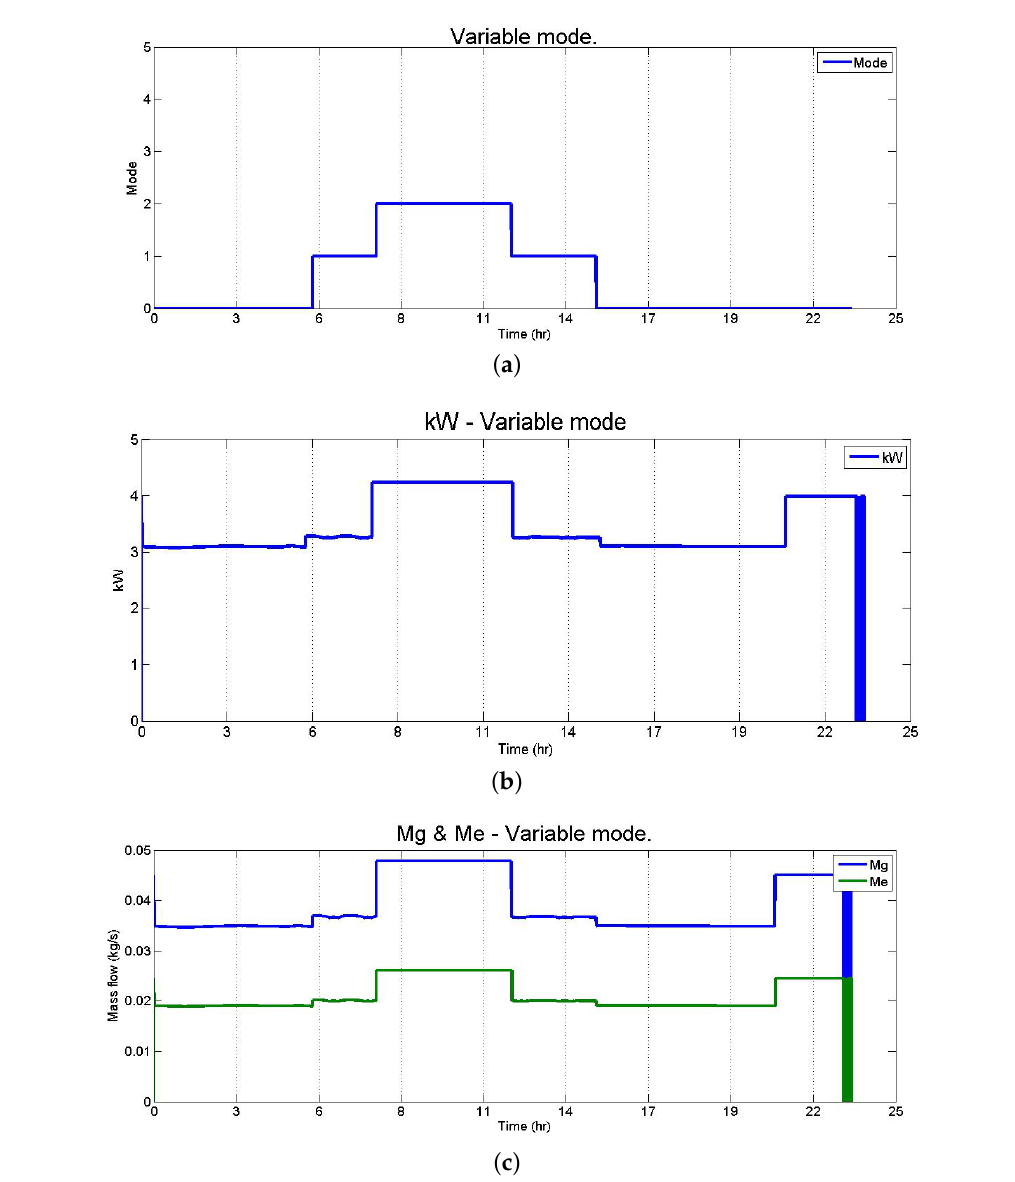
Figure 21. Behavior of the variable mode of use of the cooling system defined by the end user for a radiation of 500 kW/m 2 . ( a ) Variable mode used; ( b ) kW of the variable mode; ( c ) mass flow for the generator and